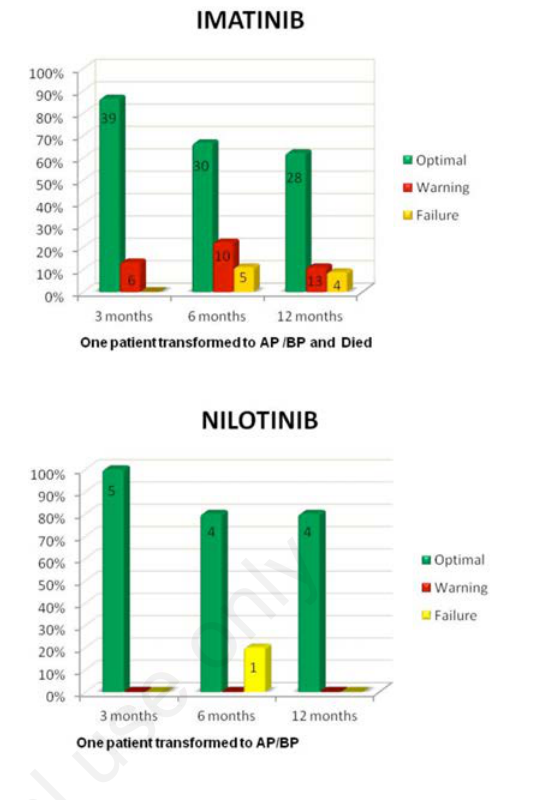
Figure 1. Results of 45 patients for imatinib first line therapy (90%) and 5 for nilotinib first line